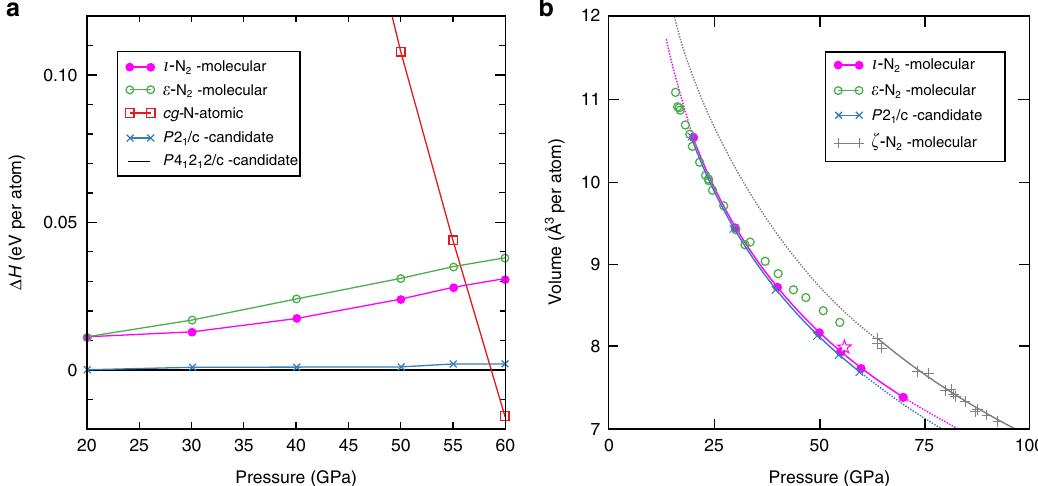
Fig. 4 The calculated enthalpy and volume per atom for the ι – N 2 structure. a Calculated PBE enthalpy differences with respect to the P 4 1 2 1 2-candidate structure of ref. 18 . The computed enthalpy of ι – N 2 is more favourable than ε – N 2 above 20 GPa. Polymeric cg – N becomes favourable at 58 GPa, in agreement with previous DFT estimates. b Calculated volume per atom of ι – N 2 and the P 2 1 / c -candidate structure of ref. 18 plotted with experimental data for ε – N 2 and ζ – N 2 . The ι – N 2 volumes are ~1% larger than the P 2 1 / c -candidate of ref. 18 . The star shows the experimentally determined ι – N 2 volume per atom at 56 GPa and ambient temperature. The experimental data for ε – N 2 and ζ – N 2 are reproduced from ref. 9 and references